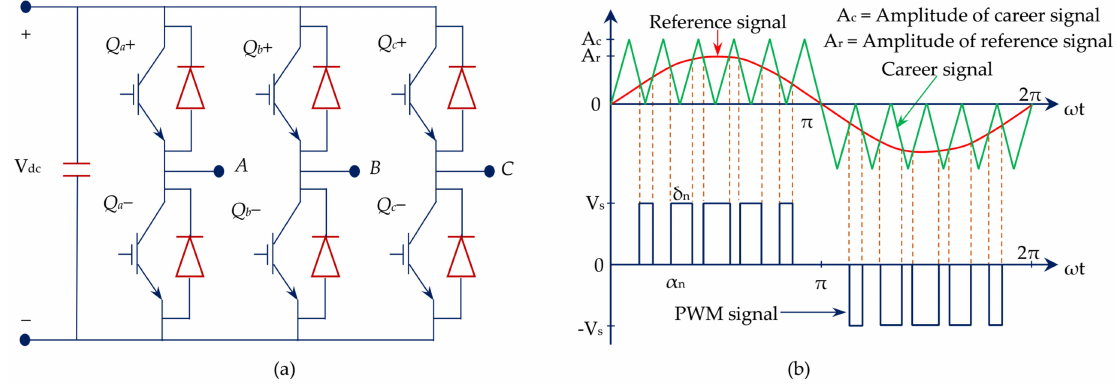
Figure 4. ( a ) Insulated gate bipolar transistor-based power inverter; and ( b ) Sinusoidal pulse-width modulation of one of the